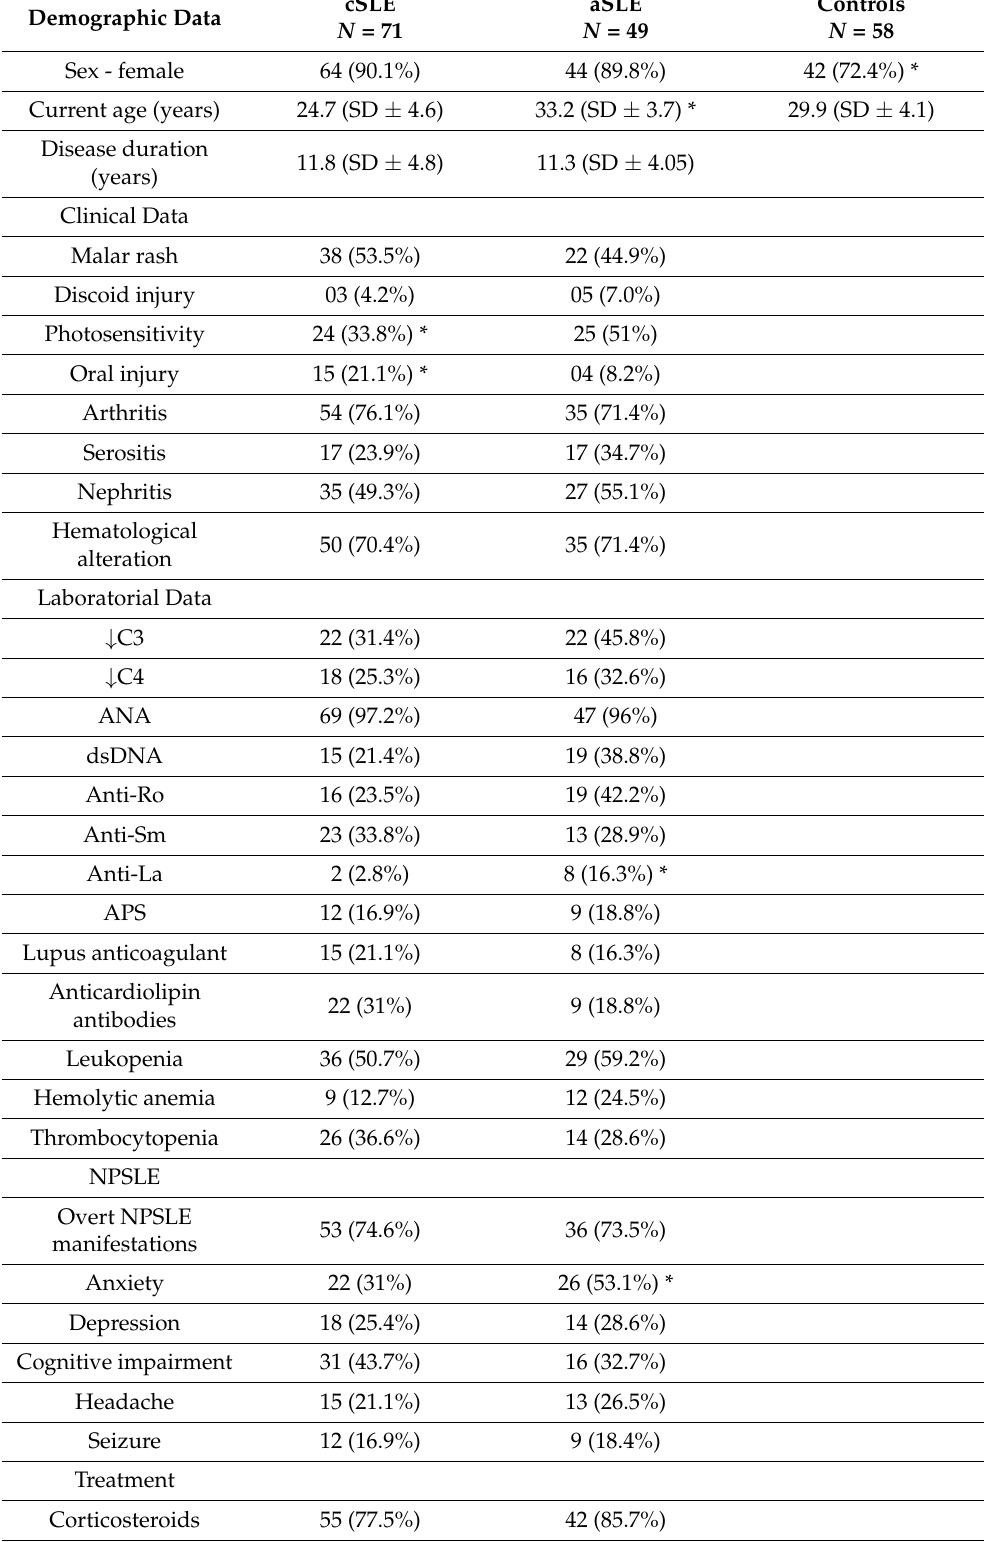
Table 1. Demographic data, laboratory findings, neuropsychiatric manifestations, and treatment in cSLE, aSLE, and the